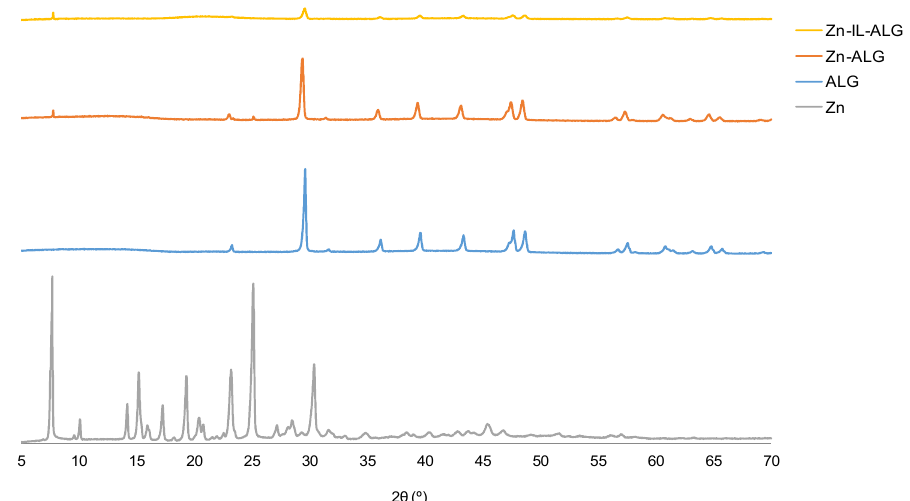
Figure 7. X-ray diffraction patterns of Zn(II)-AHBD- and [Aliquat][Cl]-impregnated alginate aerogels (Zn-IL-ALG), Zn(II)-AHBD-impregnated alginate aerogels (Zn-ALG), blank alginate aerogels (ALG) and pure Zn(II)-AHBD catalyst (Zn), respectively.